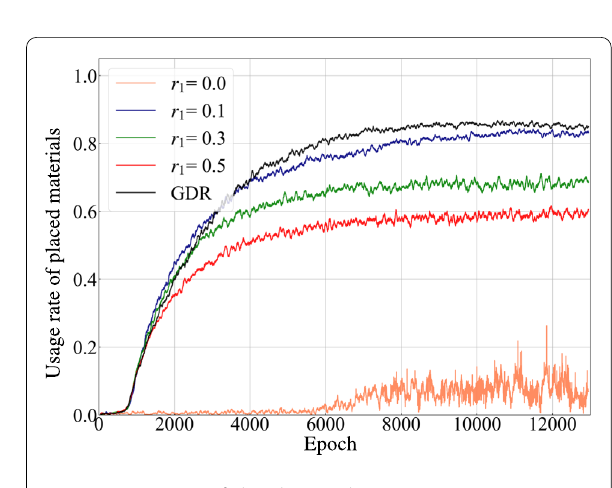
Figure 5 Usage rate of placed